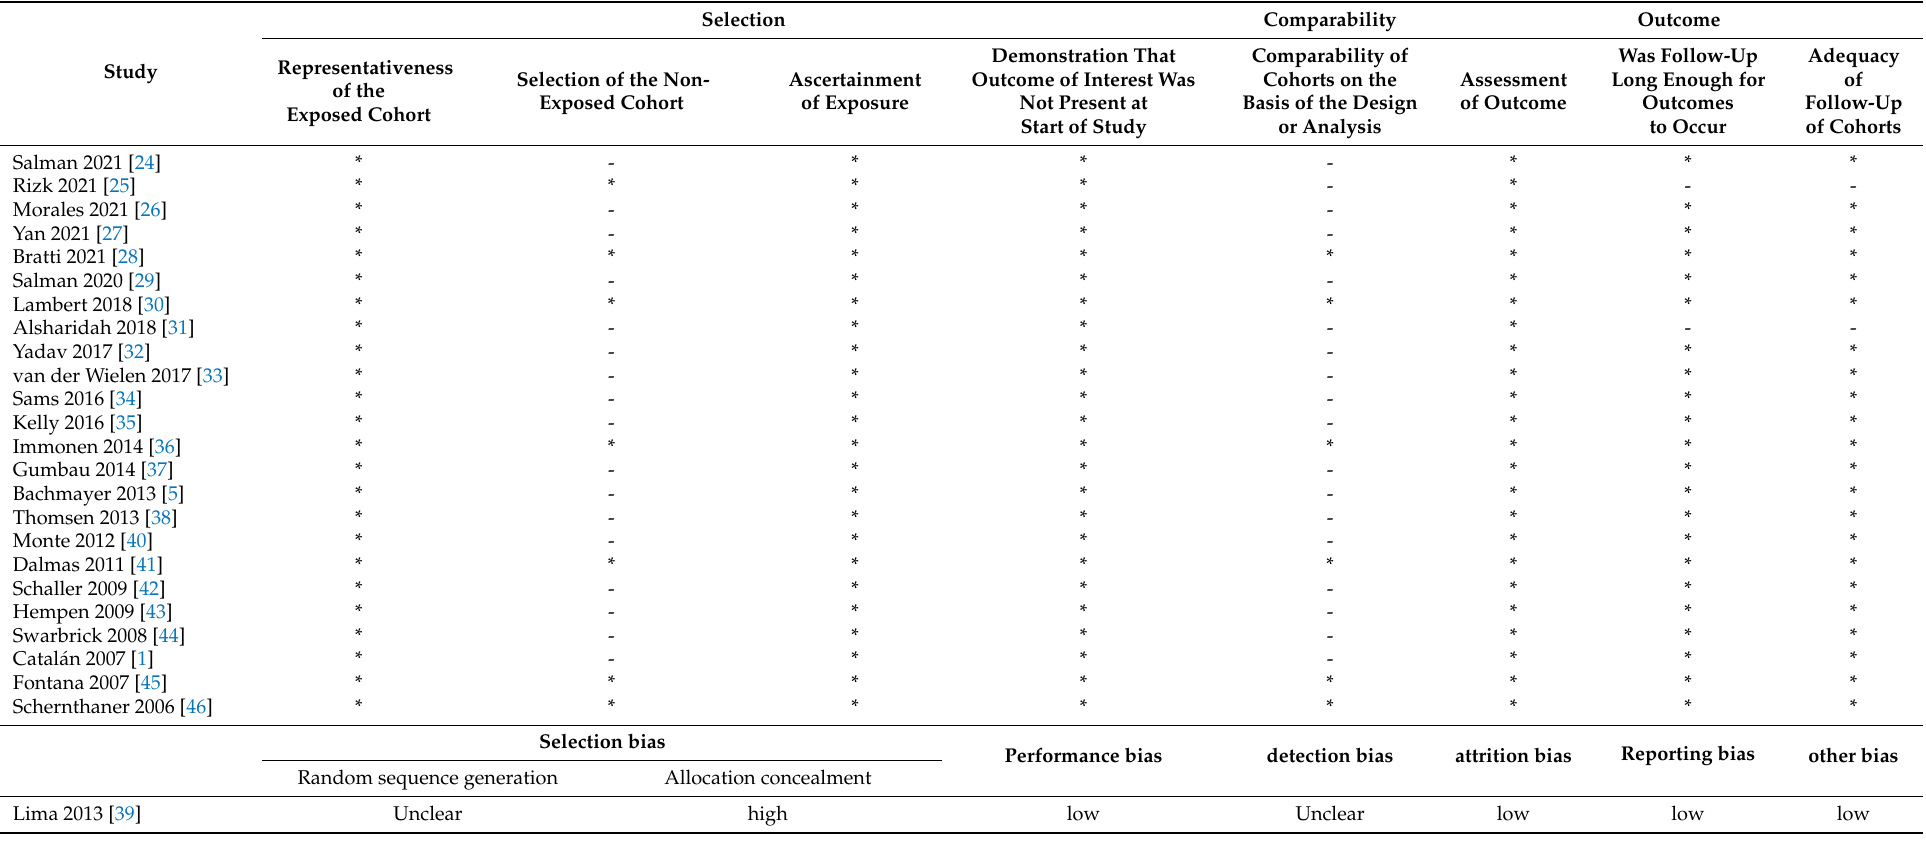
Table 2. Quality assessment of the included studies in accordance with the Newcastle–Ottawa scale (for observational studies) and Cochrane Collaboration’s tool (for randomized controlled